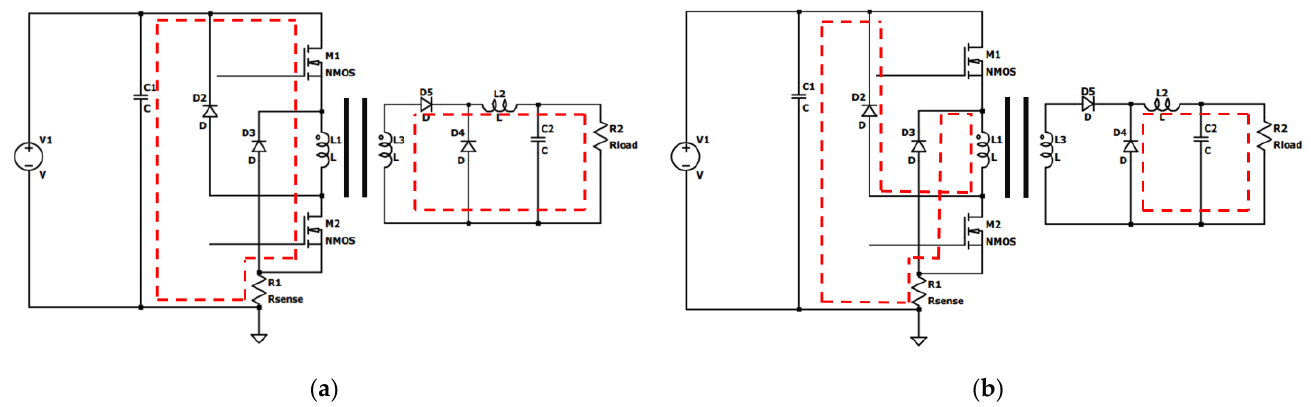
Figure 5. Two-switch forward converter cycles: ( a ) mosfet transistors are ON; ( b ) mosfet transistors are OFF.